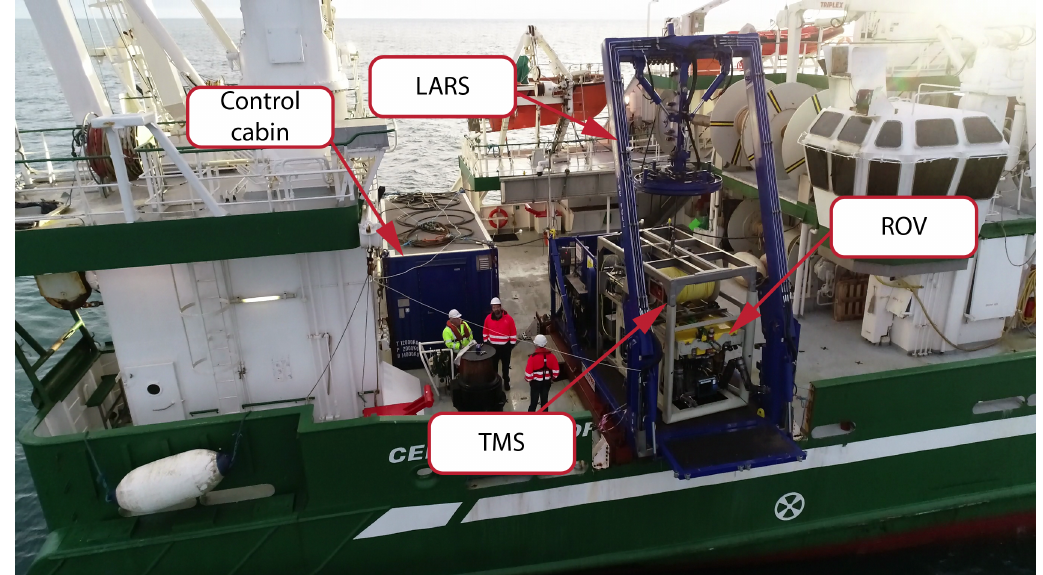
Figure 1. Experimental setup used during the offshore trials in North Atlantic Ocean during January